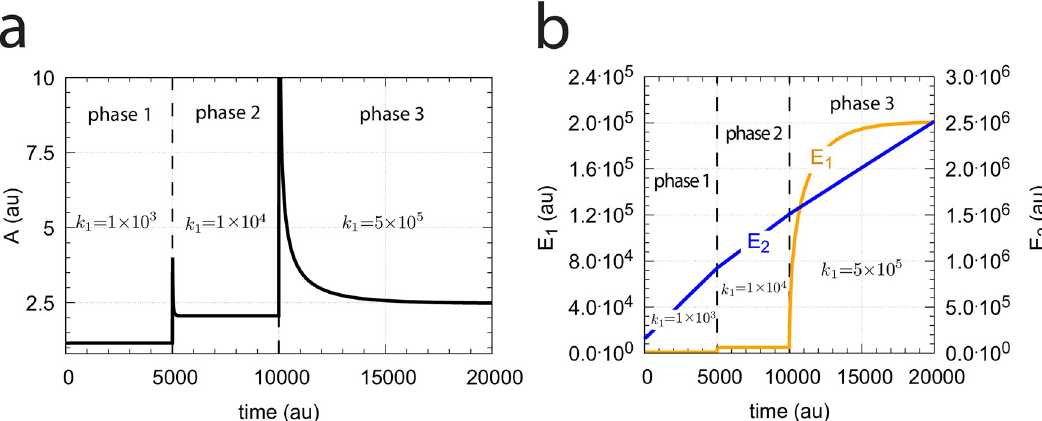
Fig 43. Under single-E control an increased perturbation k 1 moves A ss in the m5 compulsory-order ternary-complex mechanisms ( E 1 binding first to Ez ) towards A = k 7 � Ez / k 5 . (a) Phase 1: the system is that from Fig 42d with k 6 =200 and set tot k 1 =1000.0. In phases 2 and 3 k 1 is stepwise increased to respectively 1 × 10 4 and 5 × 10 5 . In phase 3 A is moved close to A set = k 7 � Ez tot / k 5 =2.5. Rate constant values as in Fig 42d. (b) Corresponding changes in E 1 and E 2 . Note the wind-up of E 2 and that only E 1 is the active controller species. Initial concentrations: A 0 =1.156, E 1,0 =866.4, E 2,0 =1.543 × 10 5 , Ez 0 =2.995 × 10 − 9 , Ez � (E 2 ) 0 =5.347 × 10 − 7 , and (E 1 � Ez � E 2 ) 0 =4.622 × 10 − 7 .